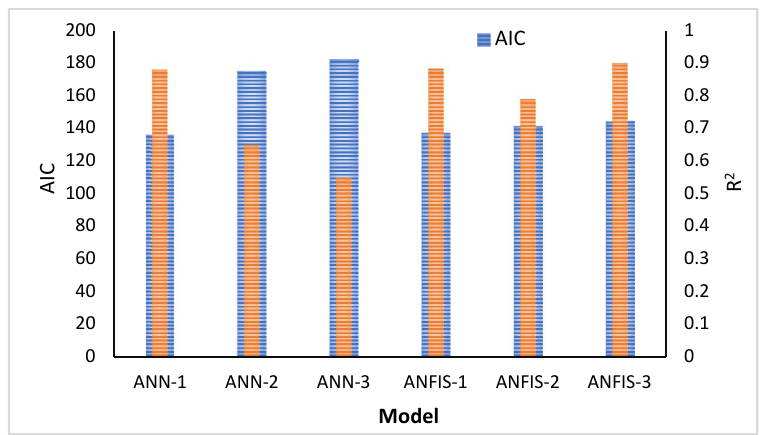
Figure 7. Performance evaluation results of the ANN and ANFIS for rainfall.